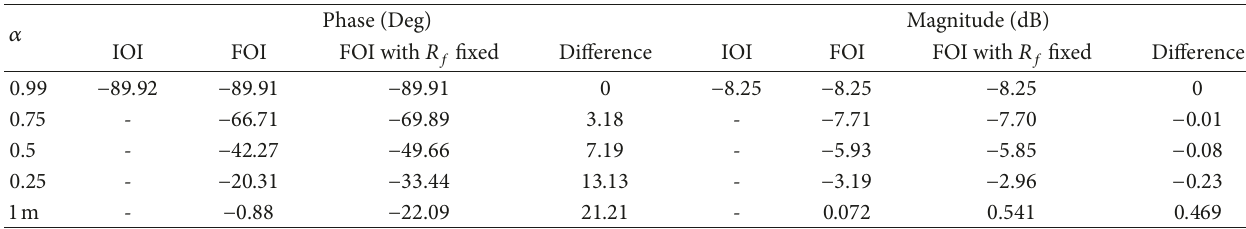
Figure 3: Behavior of IOI (black line), FOI for: 𝛼 = 0.99 (blue line), 𝛼 = 0.75 (red line), 𝛼 = 0.5 (green line), 𝛼 = 0.25 (cyan line), and 𝛼 = 1m (magenta line); and FOI with 𝑅 𝑓 fixed for 𝛼 = 0.99 (light blue line), 𝛼 = 0.75 (light red line), 𝛼 = 0.5 (light green line), 𝛼 = 0.25 (light cyan line), and 𝛼 = 1m (light magenta line): (a) magnitude response and (b) phase response. Table 1: Numerical values of the phase and magnitude response of IOI, FOI, and FOI with 𝑅 𝑓 fixed for 𝛼 ∈ (0,1) and 𝑓 = 20 kHz.